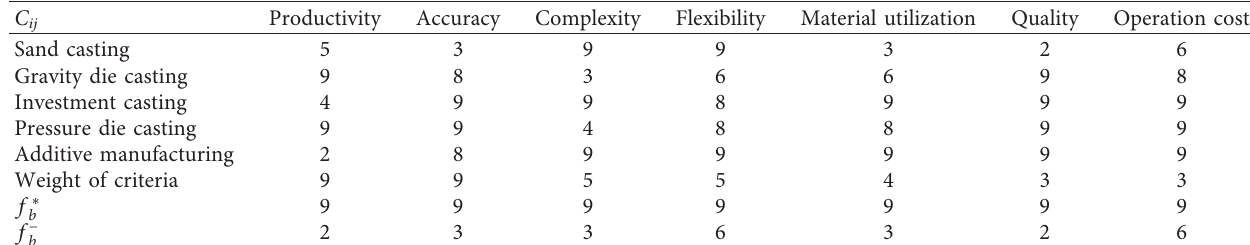
Table 11: Collected decision matrix ratings for manufacturing